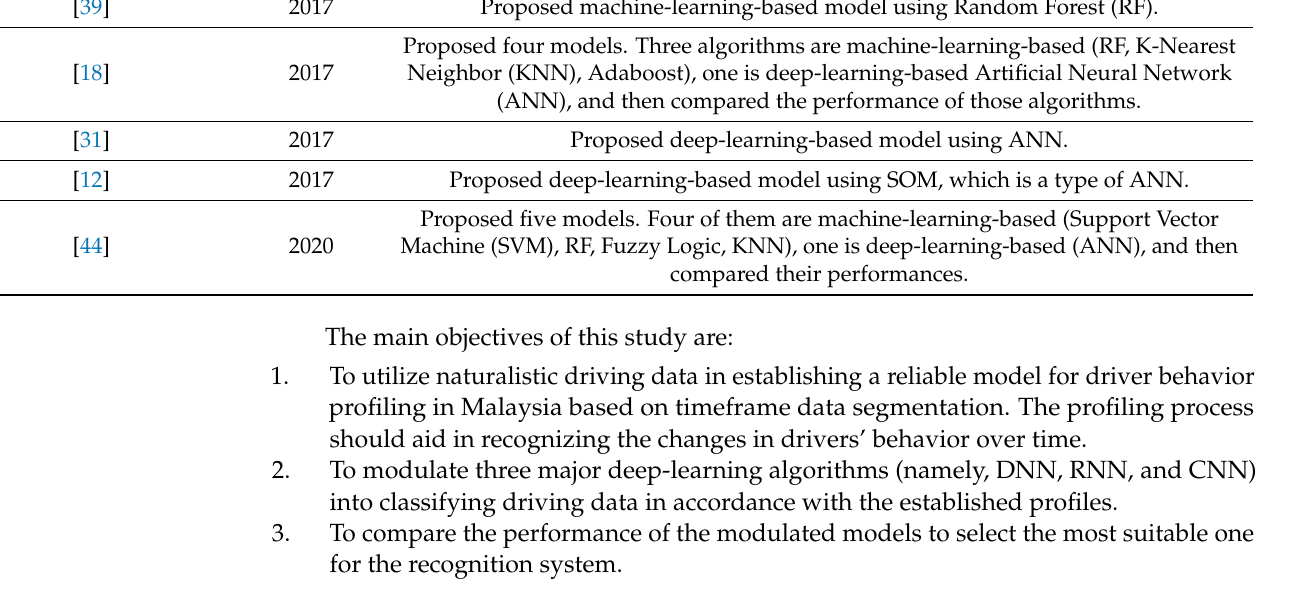
(ANN), and then compared the performance of those algorithms. Proposed deep-learning-based model using